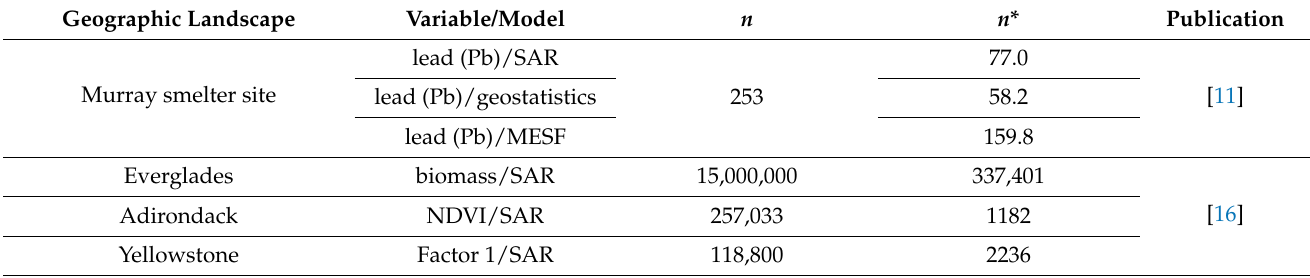
Table 1. Selected illustrative effective geographic sample sizes.